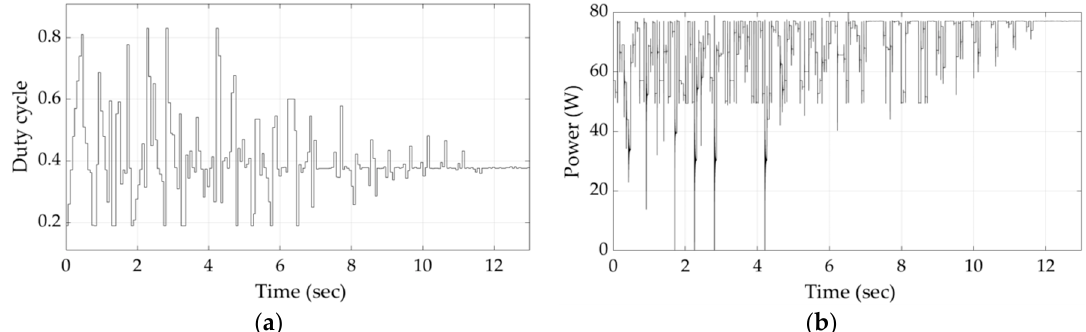
Figure 18. Results during execution of the PSO-based GMPPT process for shading pattern 9: ( a ) duty cycle versus time and ( b ) PV array output power versus time.